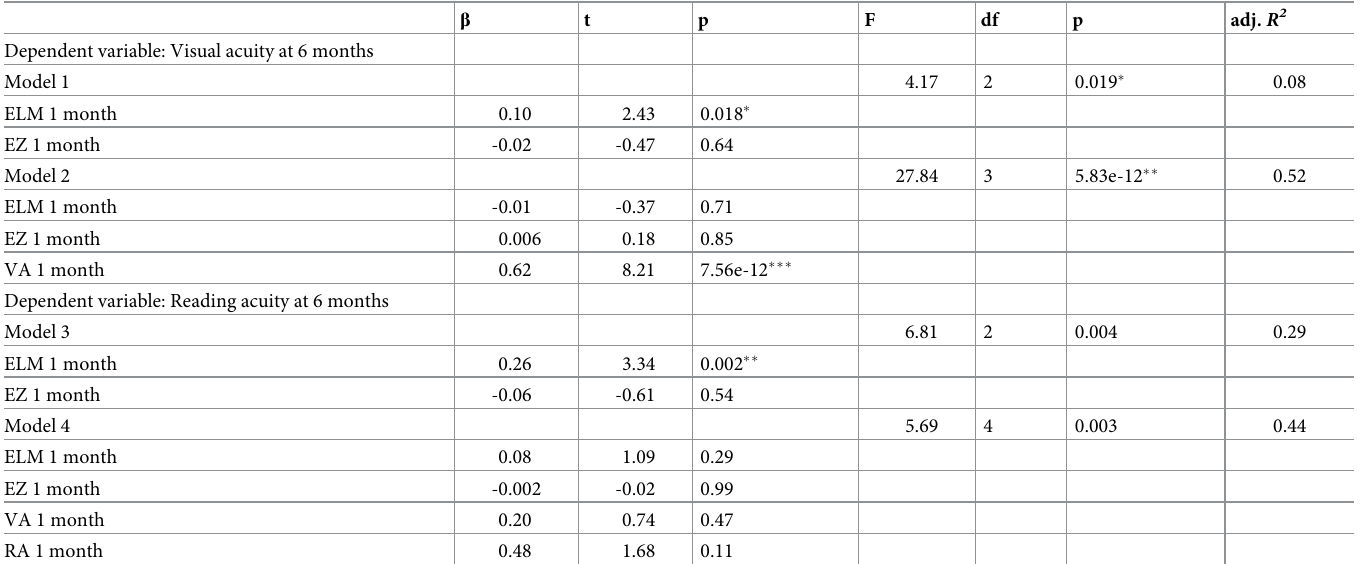
Table 1. Results of the multiple linear regression